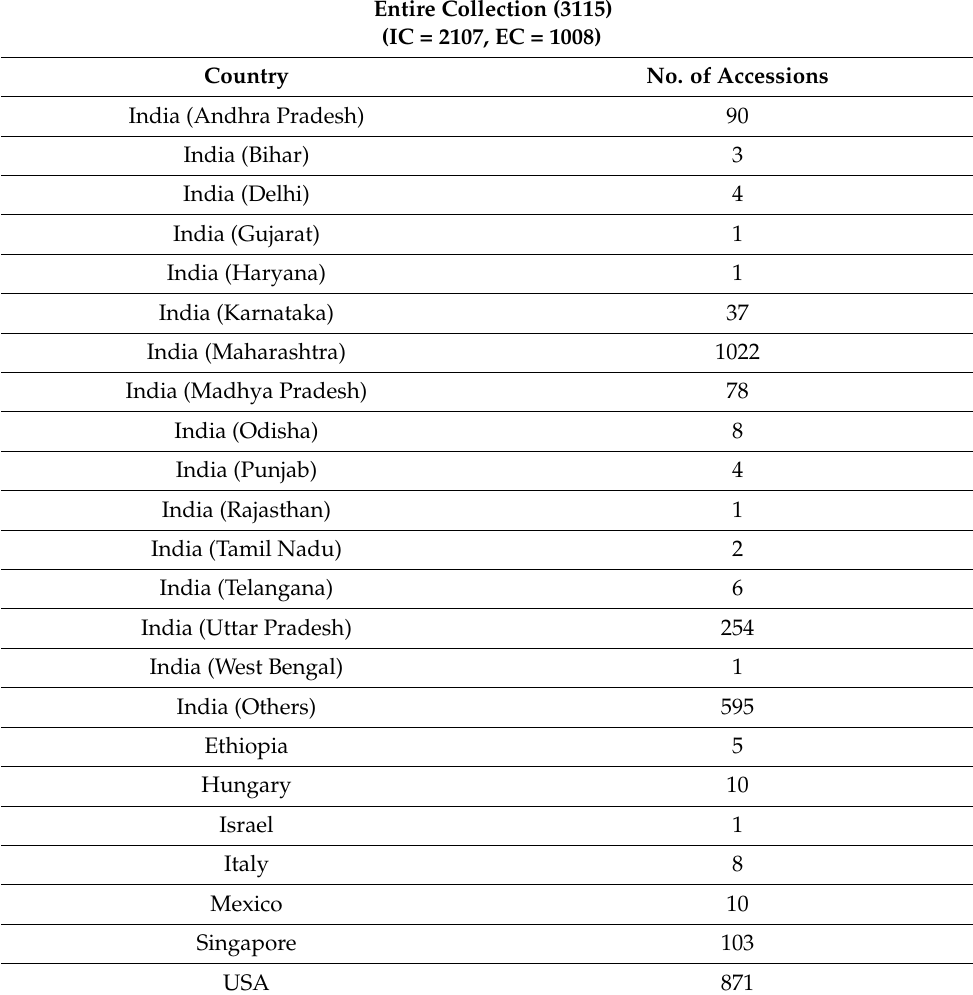
Table 1. Details of the 3115 safflower accessions used in the